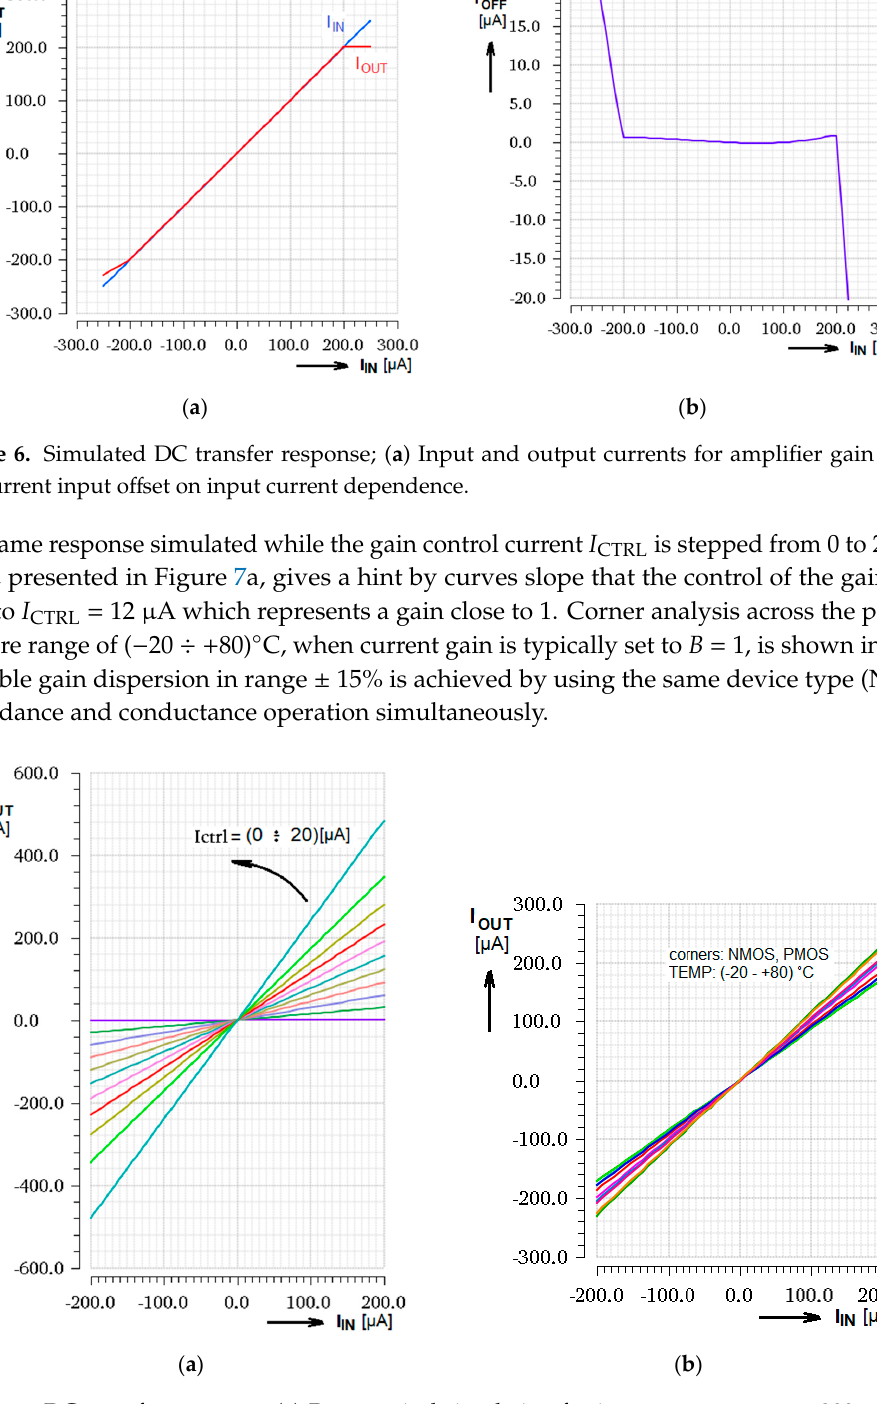
Figure 7. DC transfer response; ( a ) Parametrical simulation for input current range ± 200 µA and stepped gain setting current I CTRL from 0 to 20 µA; ( b ) Corner analysis for typ. current gain B = 1 ( I CTRL = 12.5 µA).